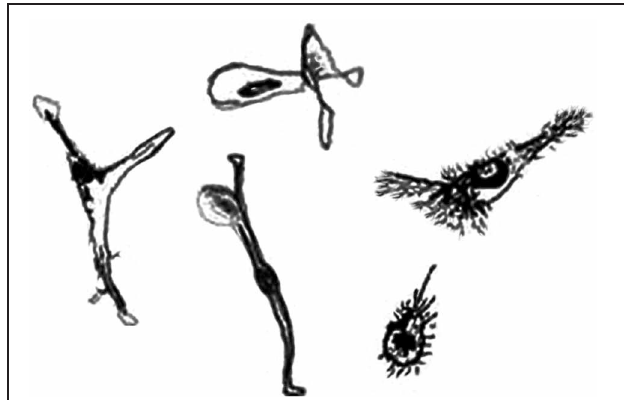
FIGURE 6 | Drawings of representative microglia grown in the laboratory. Cells grown in culture tend to appear different than microglia found in live animals. Art by Thomas R.